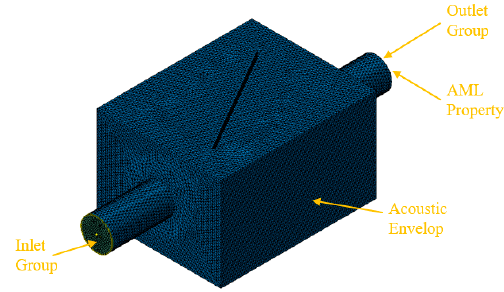
Figure A1. The FEM model of the REC.